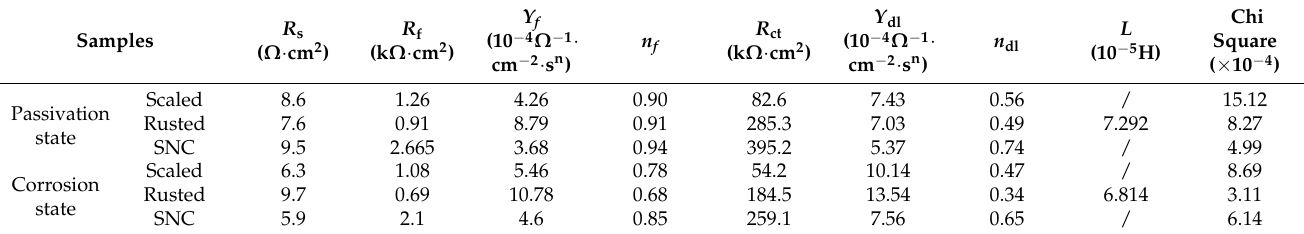
Table 2. Fitted electrochemical parameters for rebars exposed to SCPS during passivation and